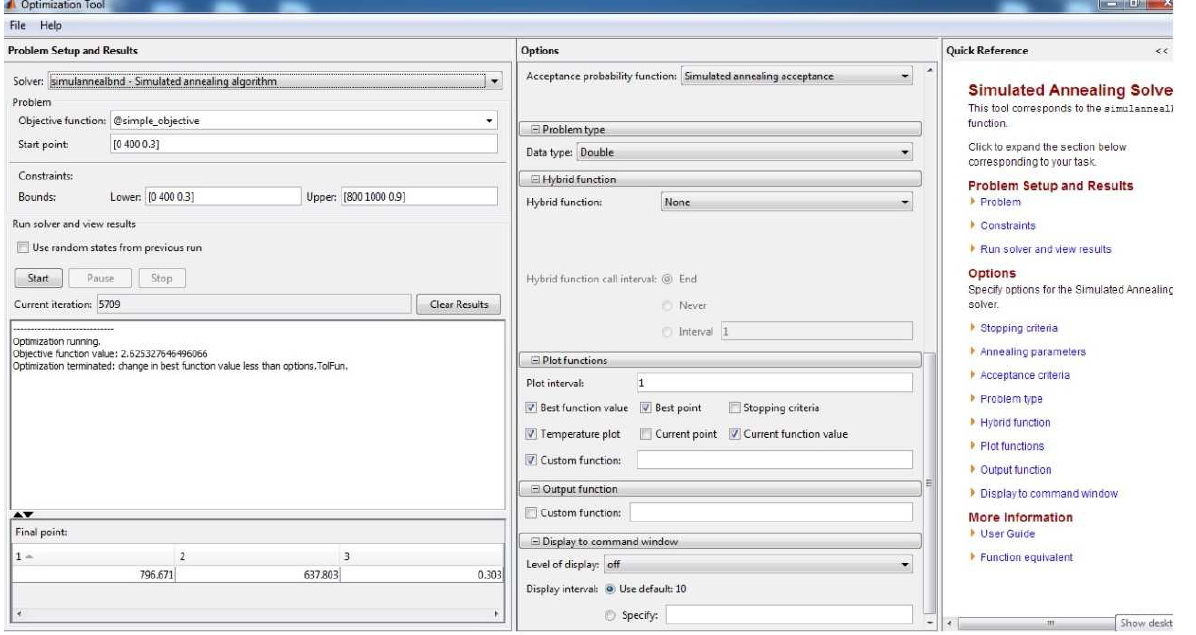
Fig. 11. Applying of Simulated Annealing Algorithm (R